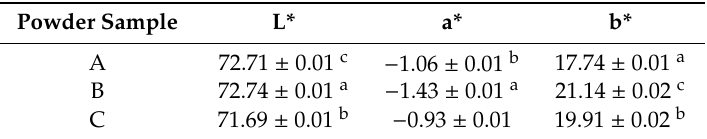
Table 4. Color values of FOCE powders.